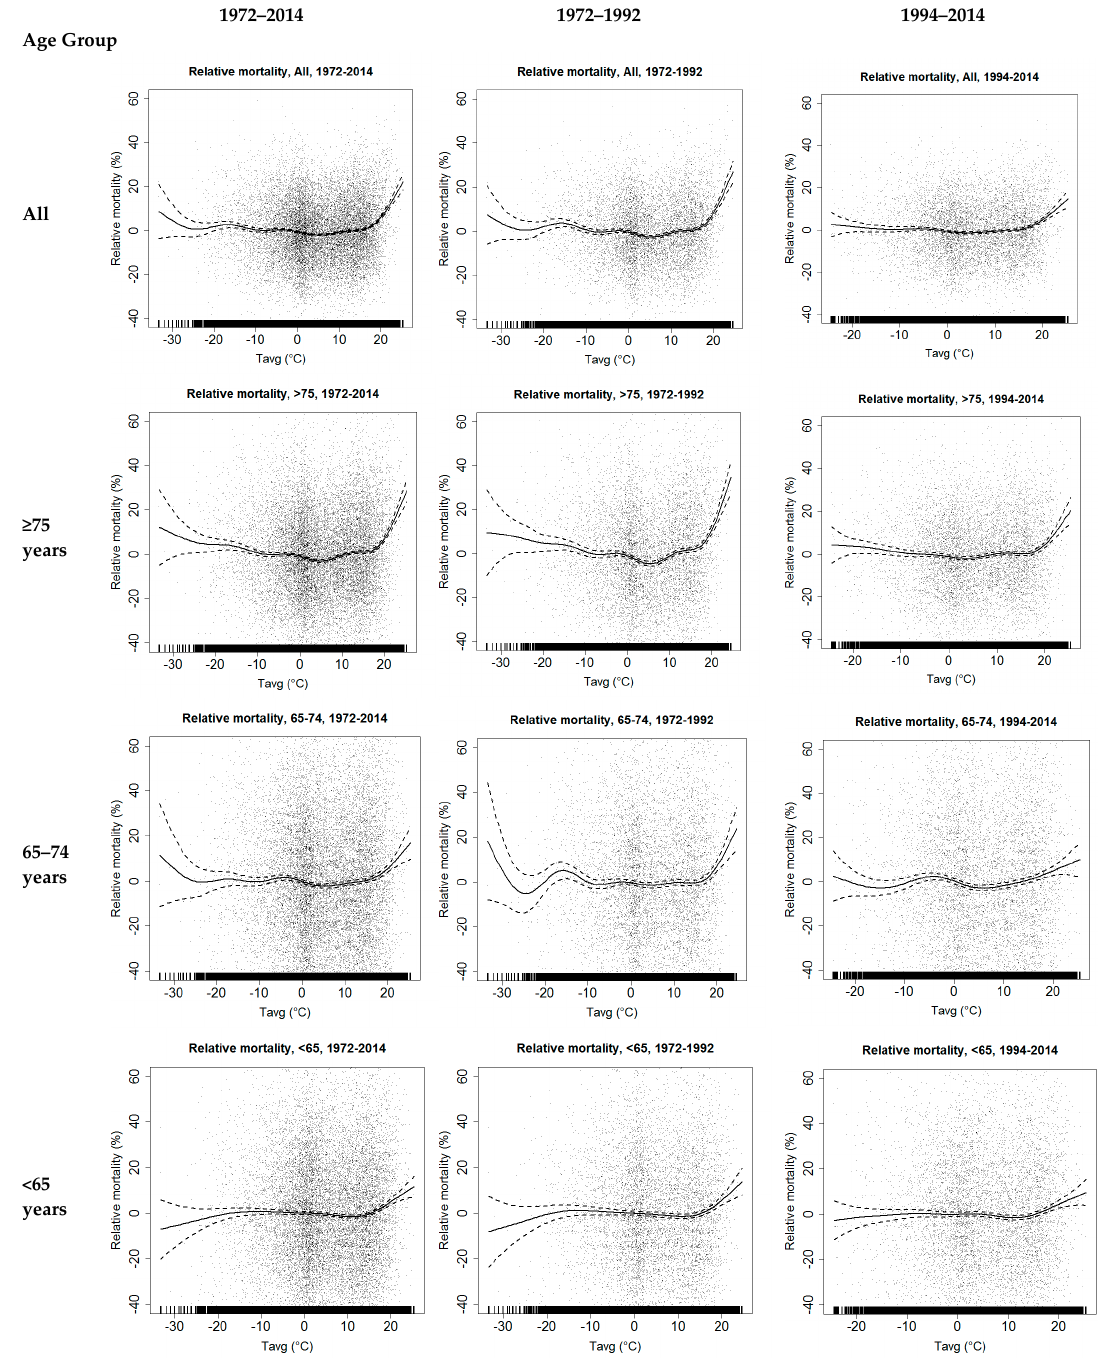
Figure 3. Scatterplots of relative mortality in different age groups and the daily mean temperature (T avg ) in the Helsinki-Uusimaa hospital district in the period of 1972–2014 and in two 21-year time periods, 1972–1992 and 1994–2014. GAM fitted to the data (solid curves) with 95% confidence intervals (dashed curves).